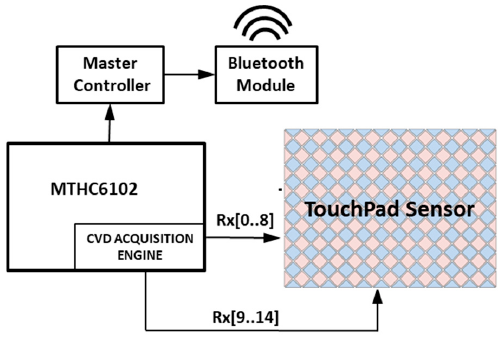
Figure A5. Electronic System Block Diagram.